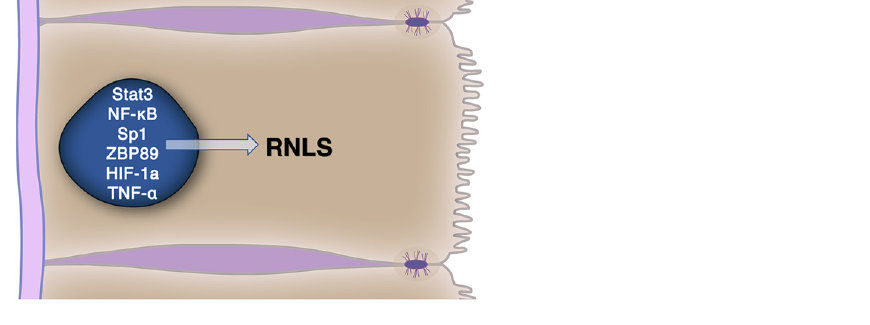
Figure 2. Renalase gene expression is regulated by a range of transcription factors, several of which are linked to proinflammatory responses. To investigate these pathways as well as RNLS function, our laboratory generated a rabbit monoclonal antibody (m28) to the human RNLS aa220-239 RP-220 peptide that en- codes for its prosurvival activity. The antibody inhibited the growth of cultured pancreatic cancer cells as well as in vivo tumors growth in a murine model of pancreatic cancer. This was associated with a significant reduction in both RNLS expression and STAT3 (both phosphorylated and total), also supporting the presence of a positive feedback loop. The inhibition of RNLS and reduced STAT3 signaling were associated with decreased cell pro- liferation and increased apoptosis [11]. Similar RNLS-dependent STAT3 signaling was found in Panc1 pancreatic cancer cells and the human kidney HK-2 cells [10]. A link be- tween RNLS expression and STAT3 was also observed in a model of fatty liver disease [8]. However, a RNLS – STAT3 interaction was not found in macrophages, suggesting that the relationship could vary among tissues [11]. Another potentially important RNLS regulatory pathway that may be relevant in the context of both ischemic injury and cancer relates to the four potential HIF-1 α -binding motifs identified within the promoter region of RNLS. These are responsible for HIF-1 α - induced increases in RNLS expression. In HIF-1 α knockdown mice, the genetic deletion worsened experimental ischemia/reperfusion (I/R) cardiac injury compared to wild-type (WT) mice. Injection of RNLS reversed the effects of HIF-1 α deletion on the excess deteri- oration of cardiac function [39]. This indicates a significant role for RNLS in mediating the protective effects of HIF-1 α , at least in the context of I/R cardiac injury. Together, the involvement of these factors suggests complex, multi-faceted roles for RNLS action and regulation of its levels that will likely affect divergent and distinct signaling pathways. 5. Renalase Signaling 5.1. Enzymatic Activities of RNLS The potential enzymatic functions of RNLS1 were the focus of the original studies of the protein [1,4,26,27]. Although RNLS’s in catecholamine metabolism remains unclear (although direct or indirect effects are very likely), interests in the enzymatic properties of RNLS, which may be most relevant to the function of an intracellular pool, has shifted to the oxidative metabolism of NAD(P)H [30,40,41]. Though the scope of studies has since broadened to include other functions of the protein (specifically its signaling capabilities),